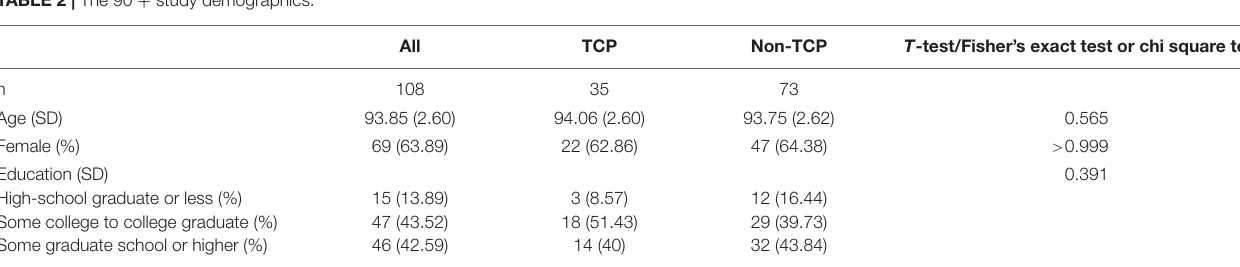
TABLE 2 | The 90 + study